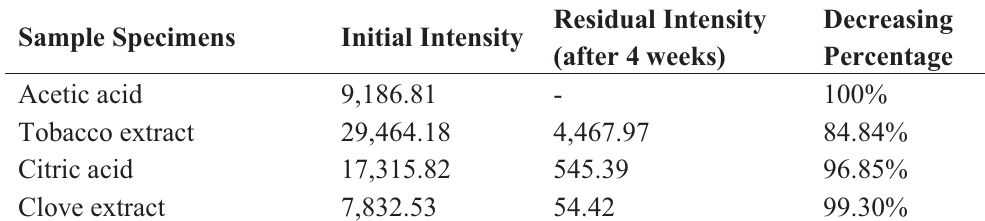
Table 6. Percentage of organic content on wood